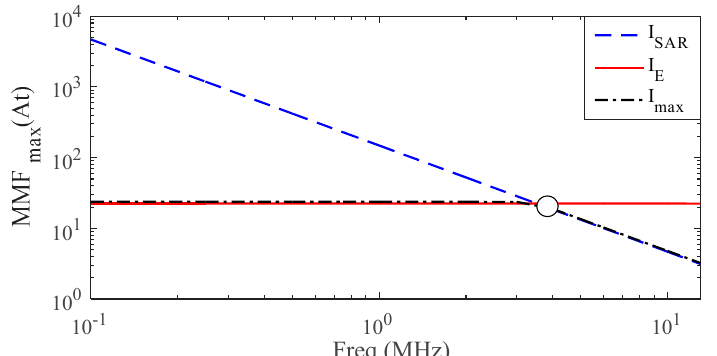
Figure 4. Maximum admissible magnetomotive force MMF vs. frequency.